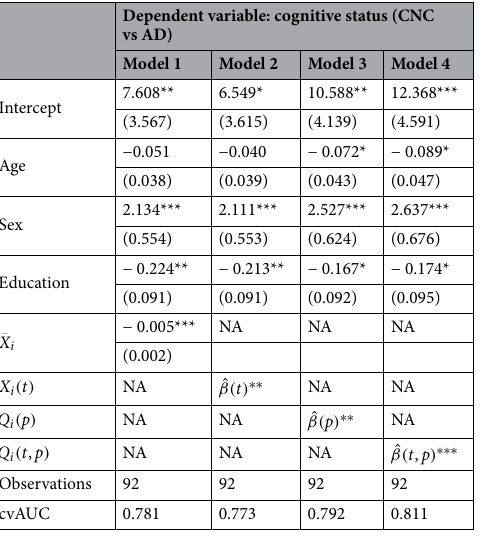
Table 2. The results of modelling cognitive status (CNC vs AD) and physical activity using Model 1–4 with an adjustment for age, sex, and education. The standard deviation of the estimated coefficients for the scalar predictors are indicated in the parenthesis. Predictors: model 1-scalar average PA, model 2–diurnal PA curves, model 3-quantile functions, model 4-SOTDR with time-by-distribution data objects. * p < 0.1 ; ** p < 0.05 ; *** p < 0.01